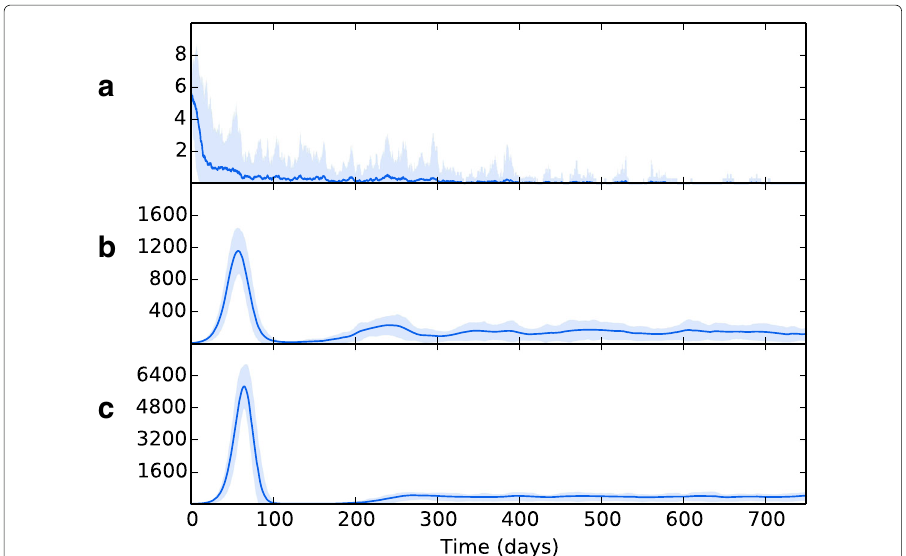
Fig. 5 The overall bacterial growth ( B ER , B ED , B IM and B ID ) within a single patch topology (Topology A). Line is mean, shading is standard deviation. a shows results using event parameters as described in Tables 3, 4, 5 and 6. Infection is contained quickly and virtually eradicated. b shows the effects of a minimal reduction in cell recruitment ( R D = 50, R M _ lung = 40) and c shows the effects of a major reduction in cell recruitment ( R D = 25, R M _ lung = 20). As recruitment is reduced, the spike of initial infection (at around 50 days) increases. In both cases, the infection is contained and remains at a reasonably steady state thereafter (latency)